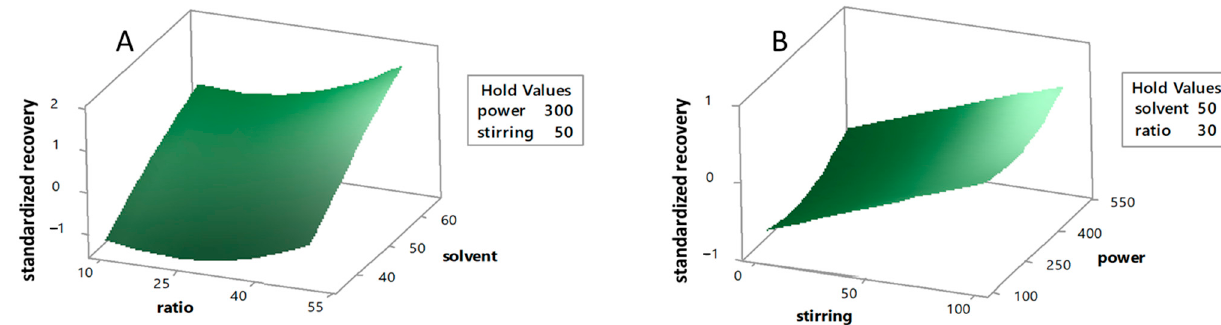
Figure 2. Estimated response surfaces for the total chromatographic area of phenolic compounds using the Box–Behnken central composite experimental design to represent the weight/volume ratio (mg/mL) compared to solvent (percentage of methanol in water) ( A ) and the effect of stirring speed compared to power ( B ).